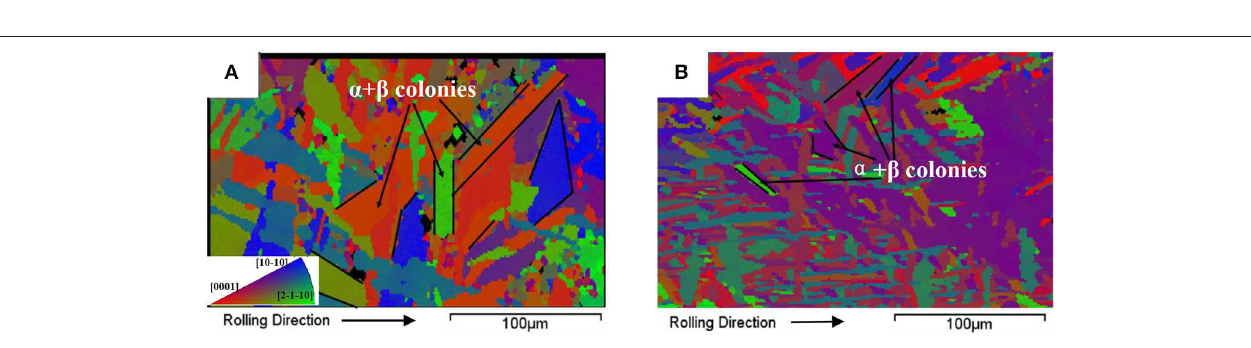
FIGURE 2 | EBSD microscopy of TMCs after heat treatment. (A) HT1. (B)